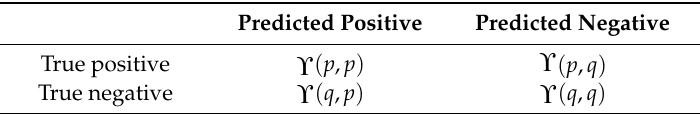
Table 1. Cost matrix for binary classification.